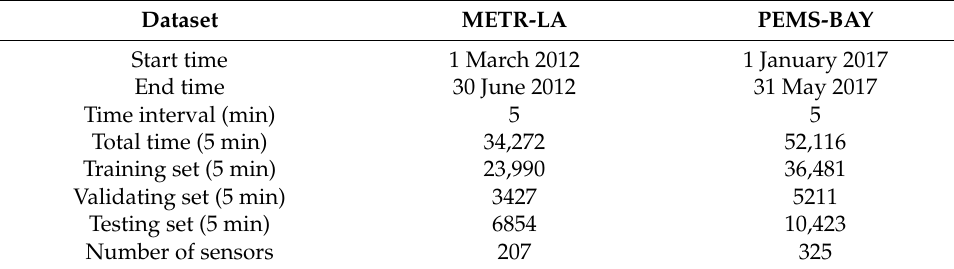
Table 1. Details of the datasets. Dataset